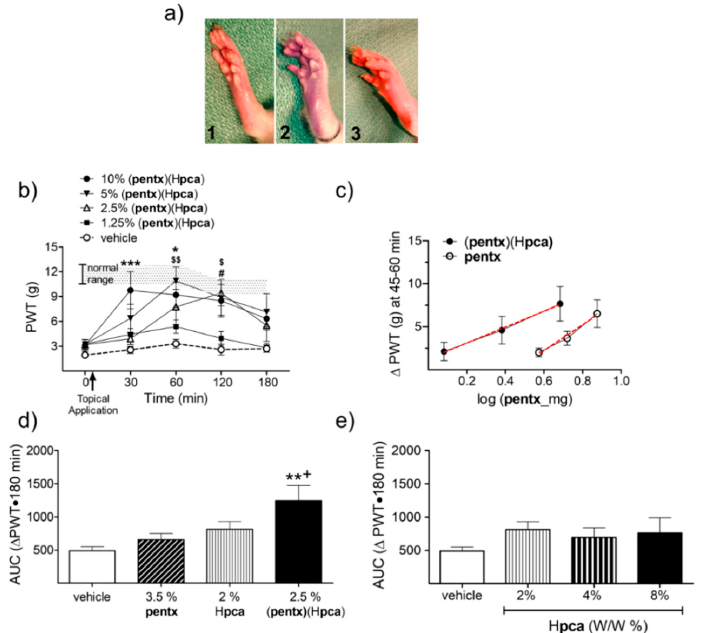
Figure 5. A comparison of the topical anti-allodynic effects of ( pentx )(H pca) to its constituent drugs on chronic post-ischemia pain (CPIP) rats. ( a ) Appearance of a rat hind paw before (1), during (2),